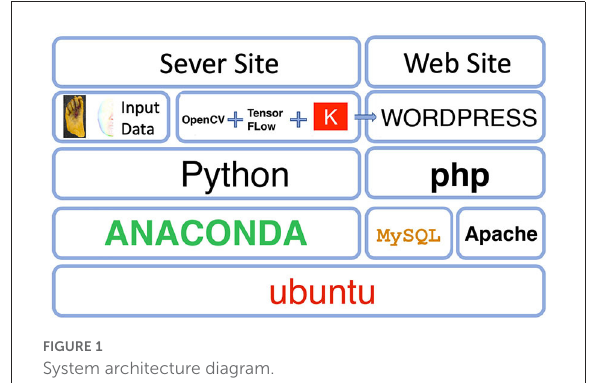
FIGURE1 System architecture diagram.